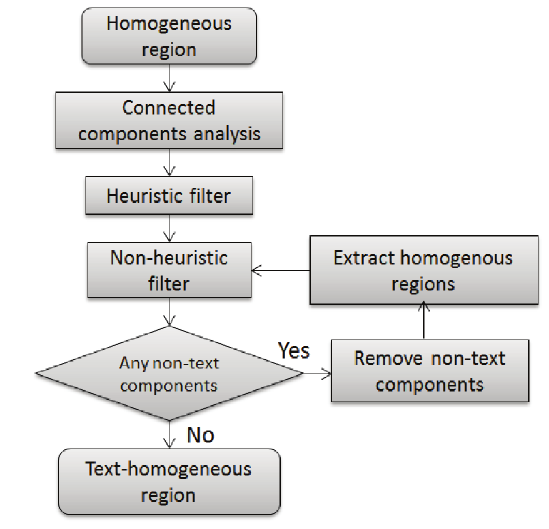
Figure 4: Flowchart of connected-component based